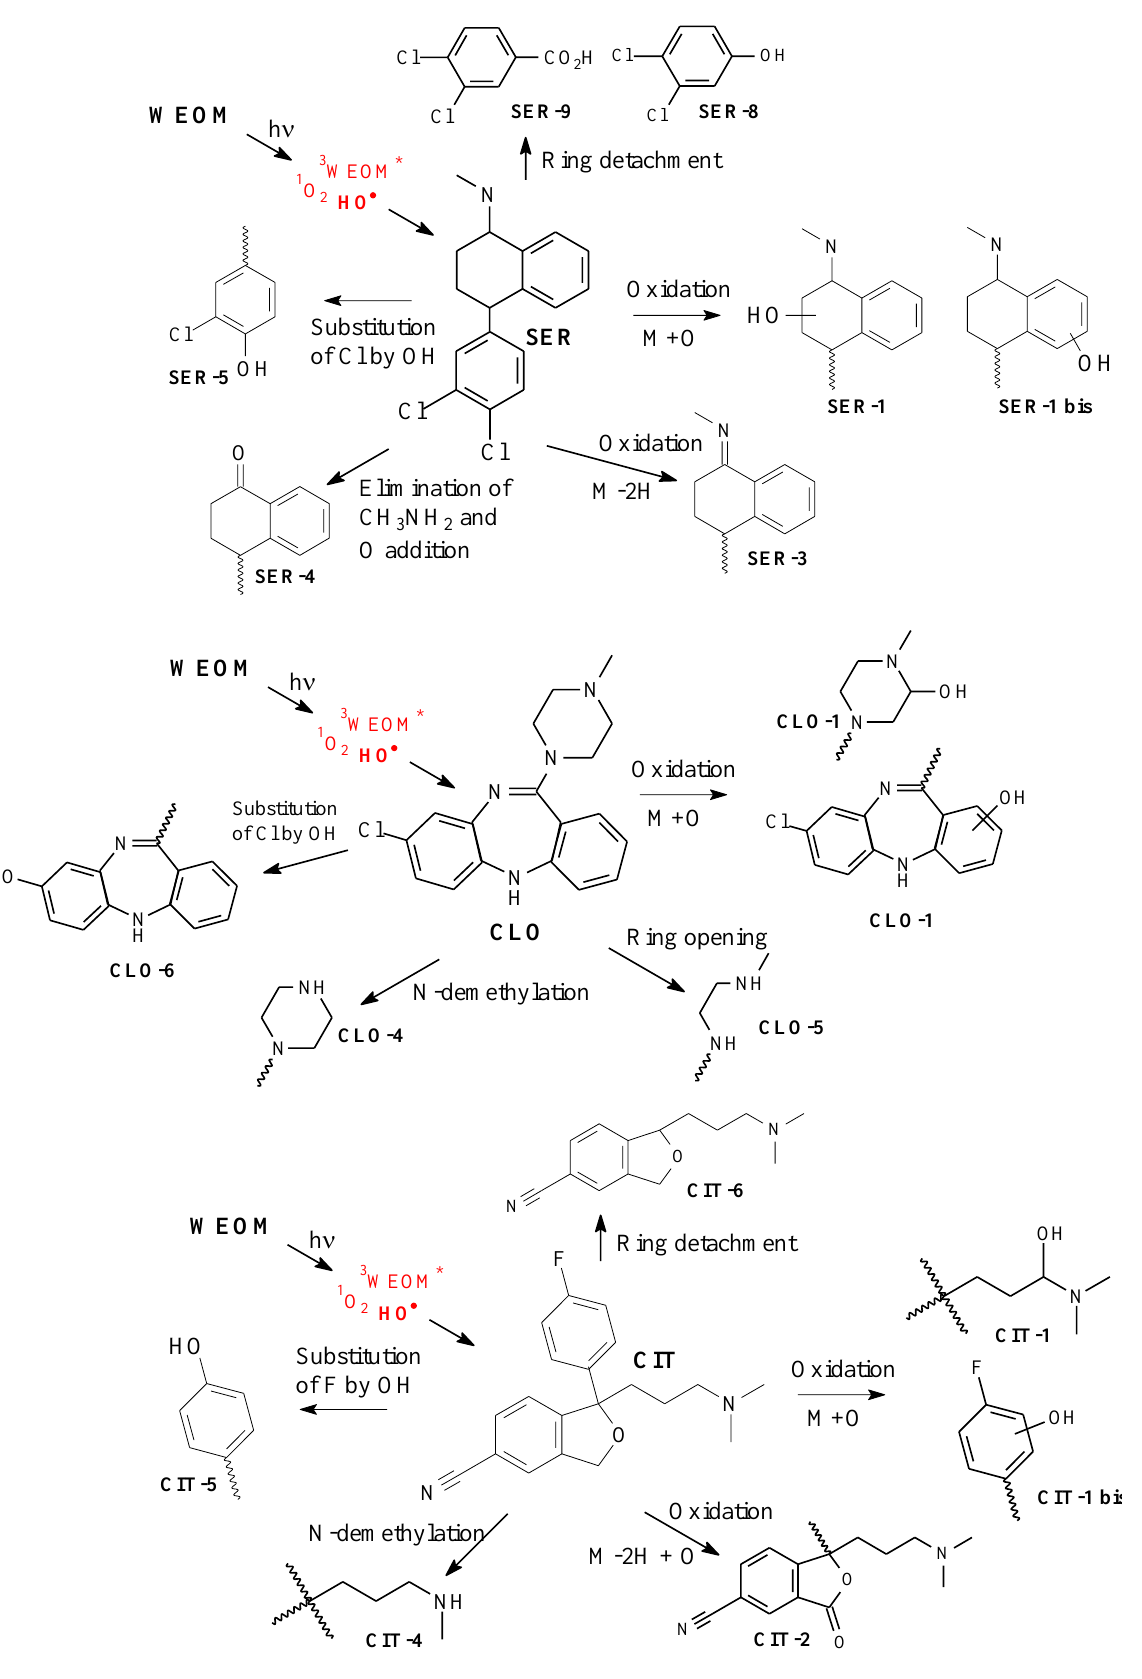
Figure 4. Photodegradation